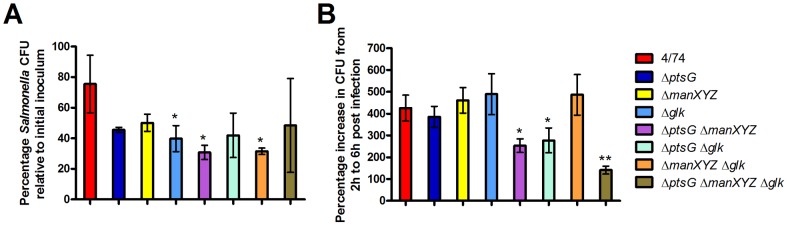
Glucose transport is required for efficient intracellular replication of S.Typhimurium in HeLa cells.Invasion (A) and intracellular replication (B) of S. Typhimurium 4/74, ΔptsG (JH3504), ΔmanXYZ (JH3501), Δglk (JH3494), ΔptsGΔmanXYZ (AT1011), ΔptsG Δglk (AT1012), ΔmanXYZ Δglk (AT1013), and ΔptsGΔmanXYZΔglk (AT1014) strains during infection of HeLa cells. (A) The chart shows the numbers of viable bacteria (expressed as percentages of the initial inoculum) within host cells at 2 h after infection. (B) The chart shows the percentage replication of bacteria between 2 h and 6 h. Each bar indicates the statistical mean for three biological replicates, and the error bars indicate the standard deviations. The significant differences between the parental 4/74 strain and the mutant strains are shown by asterisks *p<0.05, **p<0.01, and ***p<0.001.